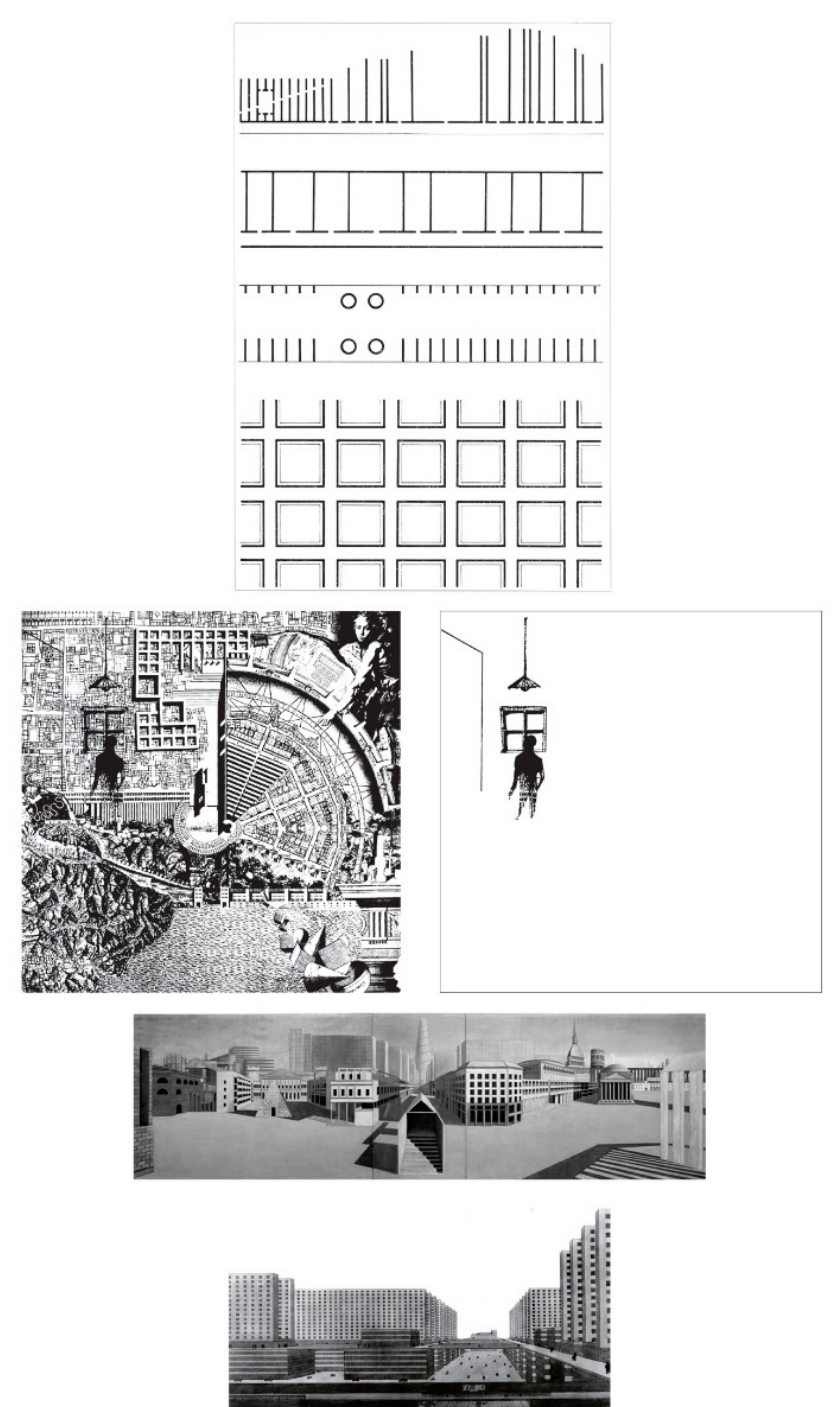
Figure 2. Montage panel by author. Rossi’s projects are in dialogue with Hilberseimer’s. Rossi developed a formally reduced language of typical elements and forms to be substituted, replaced and exchanged from project to project, always available but never settled, such as in Simmel’s notion of the exchangeability of the money economy. The shadowy figure in Rossi’s analogical city embodies a Simmel’s stranger, who comes today, stays tomorrow but is always estranged. The stranger is the analogical figure of the multitude.